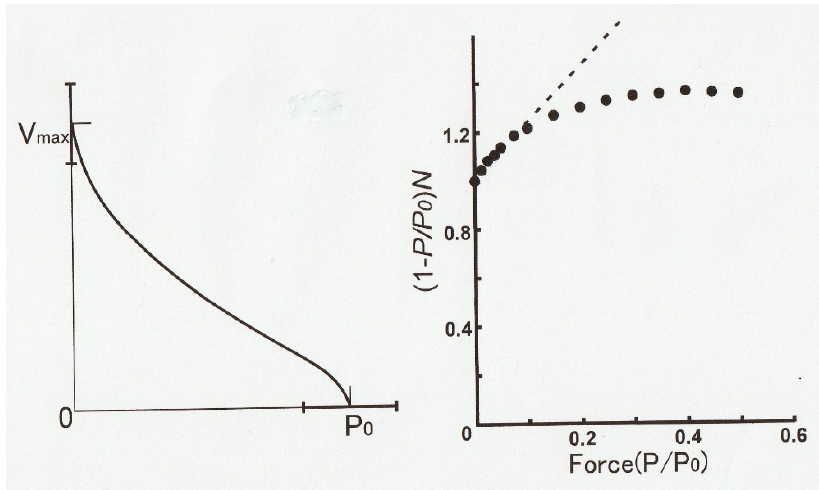
Figure 14. (Left) Averaged P–V relation of skinned muscle fibers obtained from six different fibers. Horizontal bars show SD. (Right) Linearized Hill equation plot of data points selected from the above P–V curve. The quantity, (1 − P/Po ) V (filled circles), is plotted against relative force, P /Po. If the P–V curve in A fits the Hill equation [1], the data points should fall on dotted straight line. The data points fit Hill equation only forces <~0.1 Po . From Ref. [30].